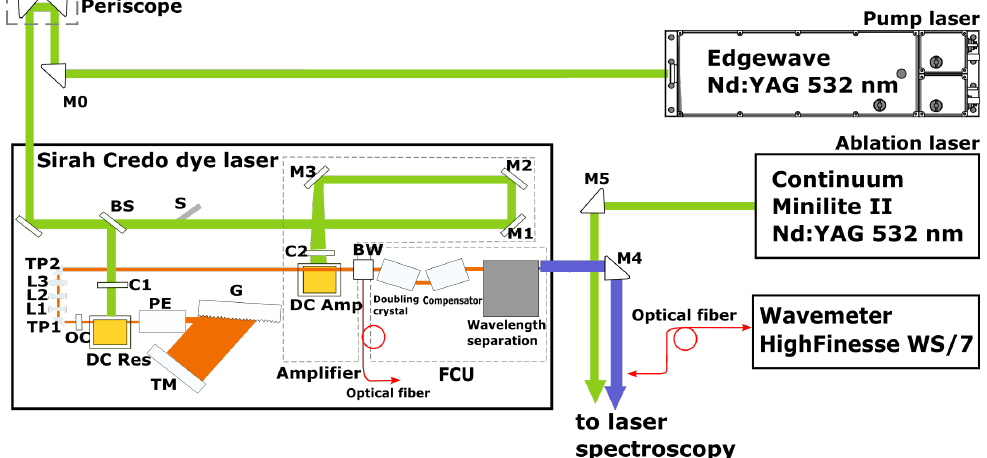
Figure 2. LRC laser system. Edgewave Nd:YAG laser pumps a Sirah Credo dye laser. Laser ablation is carried out using a Continuum Minilite II Nd:YAG laser. The wavemeter is used for wavelength monitoring. Abbreviations: M, mirror; L, lens; TP, telescopic lens; C, cylindrical lens; BS, beam splitter; BW, Brewster window; G, grating; PE, prism expander; DC Res, dye cell resonator; DC Amp, dye cell amplifier; OC, output coupler; FCU, frequency conversion